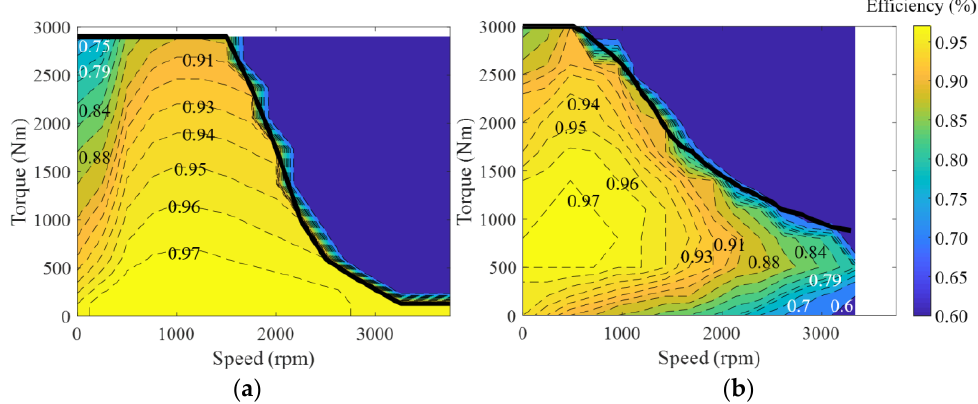
Figure 14. Efficiency map with torque-speed characteristic of ( a ) proposed 6Φ -SS-FSCW-Fer-SIP- MSM and ( b ) conventional 6Φ -FSCW-Nd-FIPMSM.